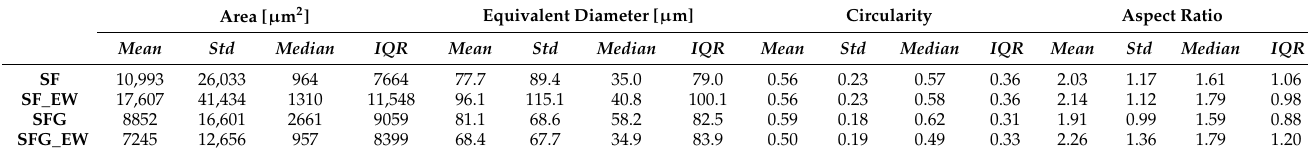
Figure 7. ( A ) Example of FE-SEM images of the four different foams involved in the porosity analysis. The scale bar was set to 100 µ m. ( B ) Box plots with the distribution histograms for the four porosity parameters investigated, namely, the area ( µ m 2 ), the equivalent diameter ( µ m), the circularity C, and the aspect ratio AR. The box charts report the IQR, mean, and median values. The upper and lower bounds were set at 1.5 IQR. ( C ) Multi-comparison bar plots with the p -value significance were reported for the area, equivalent diameter, circularity, and aspect ratio (AR). Table 2. The main statistical parameters for the pore area, equivalent diameter, circularity, and aspect ratio. The reported parameters are the mean, standard deviation, median, and IQR